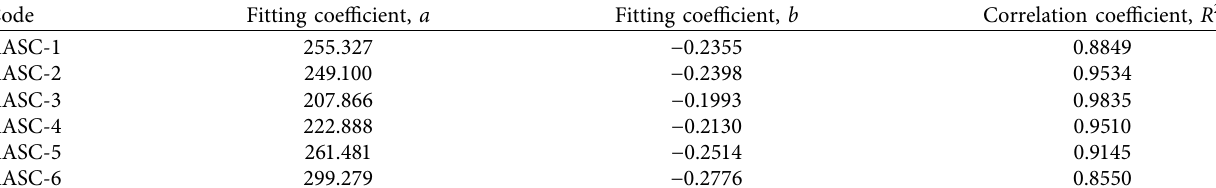
Table 8: Compressive strength attenuation power function and pertinence coefficient.